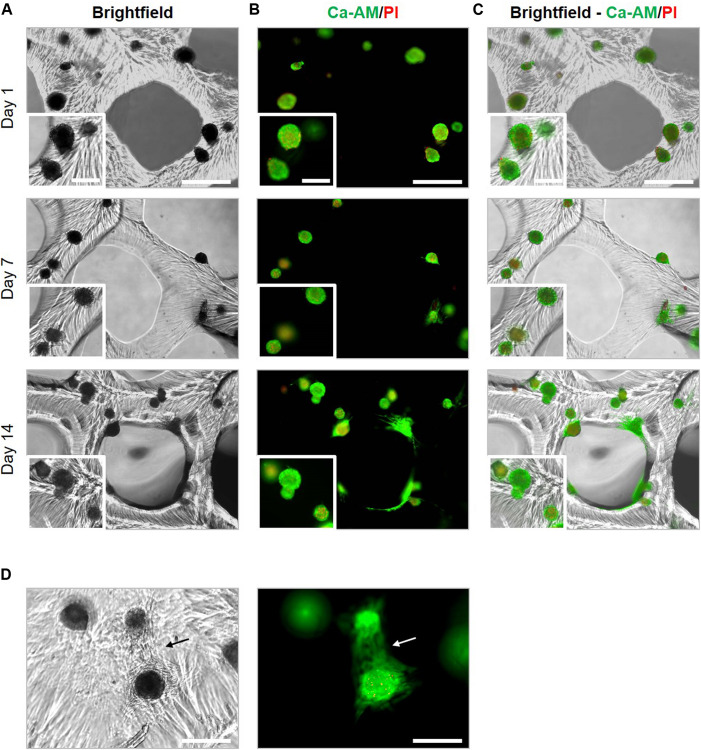
Viability of cartilage microtissues post 3D bioprinting. The viability of spheroids bioprinted at maturation stage of 14 days was assessed by live/dead staining with ca-AM/PI after 1, 7, and 14 days post printing. (A) Brightfield images, (B) fluorescent images of ca-AM/PI staining and (C) merged brightfield and ca-AM/PI images. Scale bars 500 μm (overview) and 200 μm (insert). (D) Cell outgrowth within printed constructs 14 days post printing. Cells spreading out from a surfacing spheroid (lower spheroid) toward a deeper situated spheroid (upper spheroid). Scale bar 500 μm.